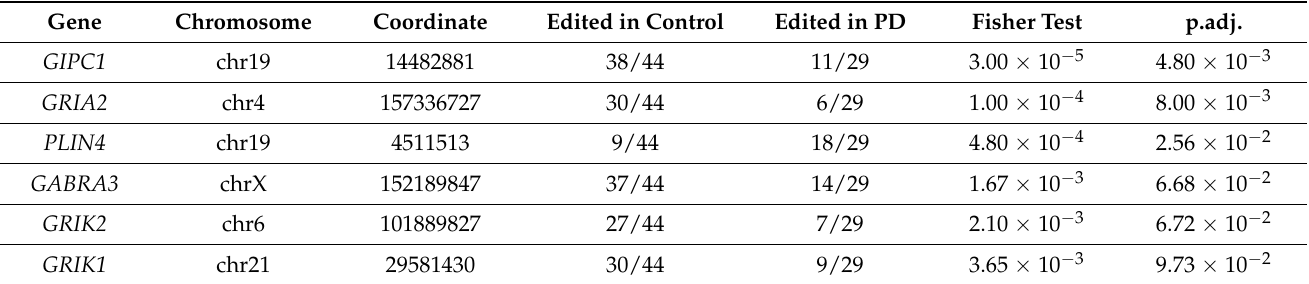
Table 1. Genes with differentially mRNA edited sites within protein-coding regions in PD patients’ brains versus the healthy